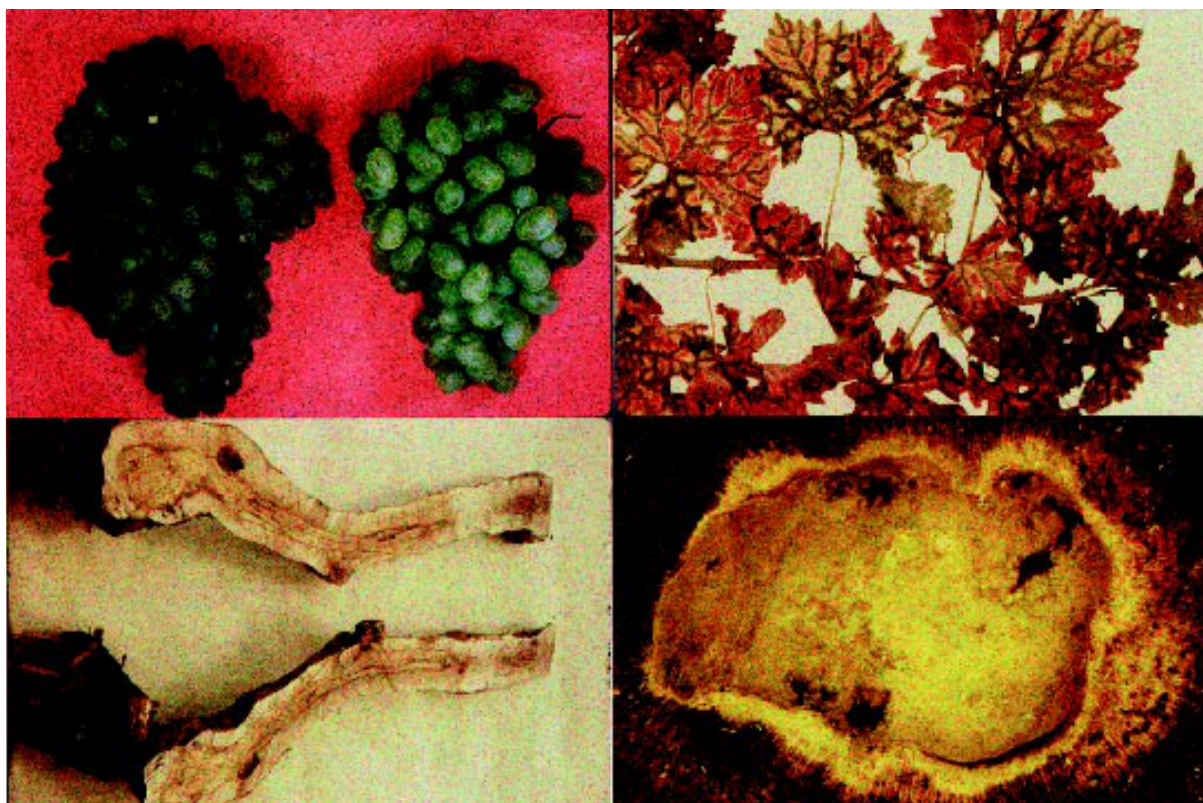
Fig. 1. Leaf, fruit and internal decay symptoms of black measles. Lower right, Phellinus igniarius, the cause of spongy decay, surrounded by abundant gum formation.